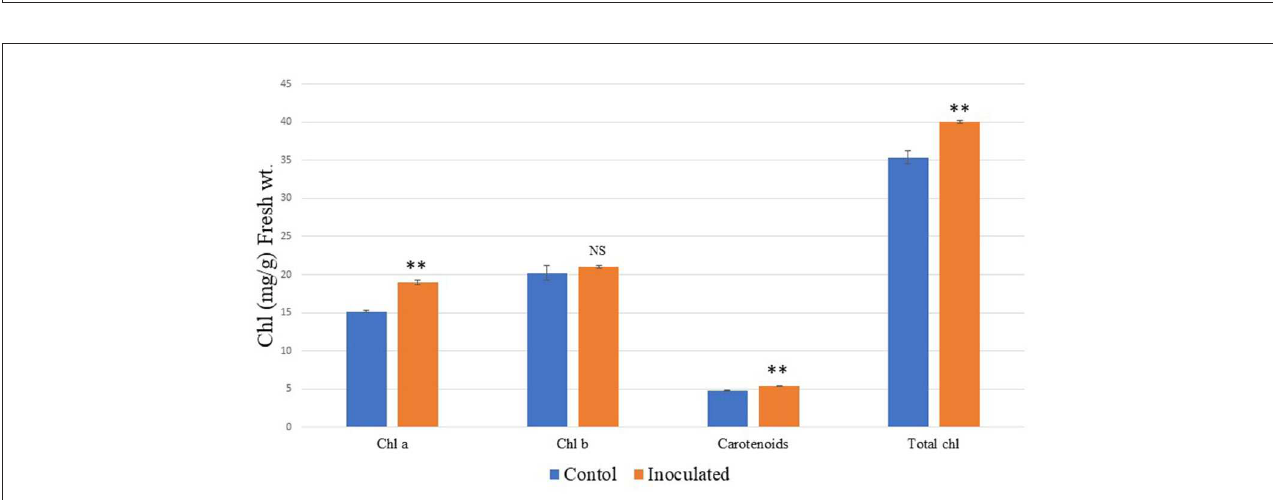
FIGURE7 Effects of bioinoculant BC-II-20 on A. paniculata plant chlorophyll content. The data showing significance are marked with NS, not significant; **extremely statistically significant.